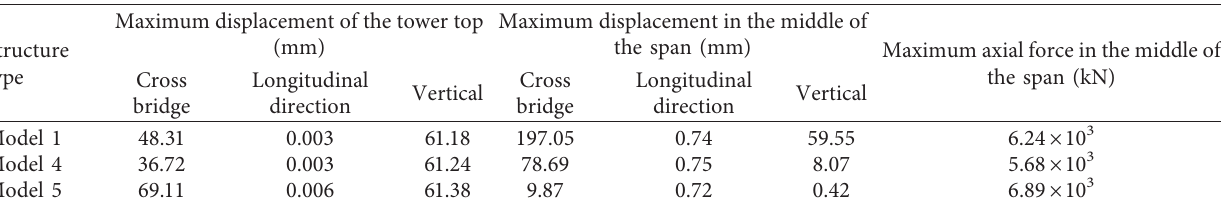
the span (kN)Cross